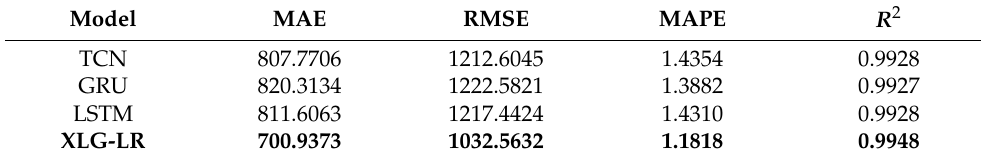
Table 9. Comparison of Power Demand Forecasting of Different Models on a Monthly Basis.